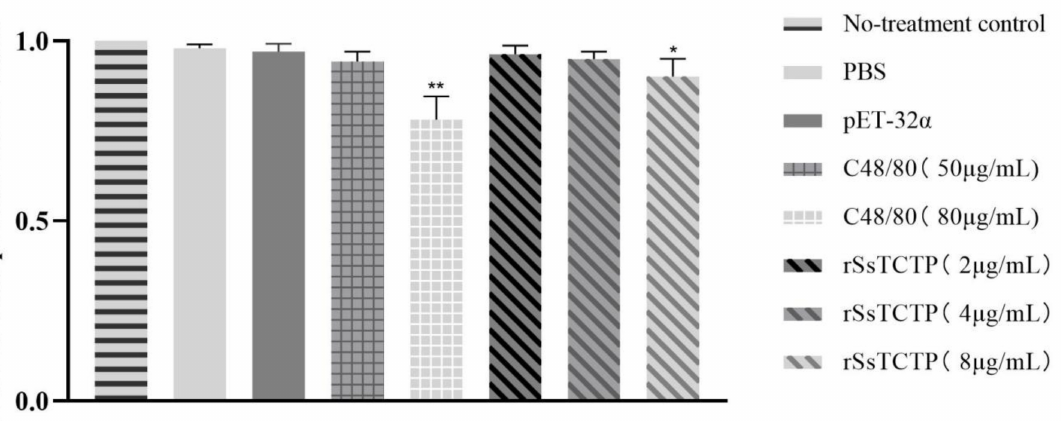
Figure 4. Effects of PBS, pET-32 α , C48/80, and rSsTCTP on KU812 cell proliferation. Data from three individual experiments (each experiment had three replicates) are shown as the means ± the standard deviation (SD). * p < 0.05, ** p < 0.01 versus no-treatment control ( t -test). rSsTCTP, recombi- nant Sarcoptes scabiei translationally controlled tumor protein; PBS, phosphate-buffered saline.